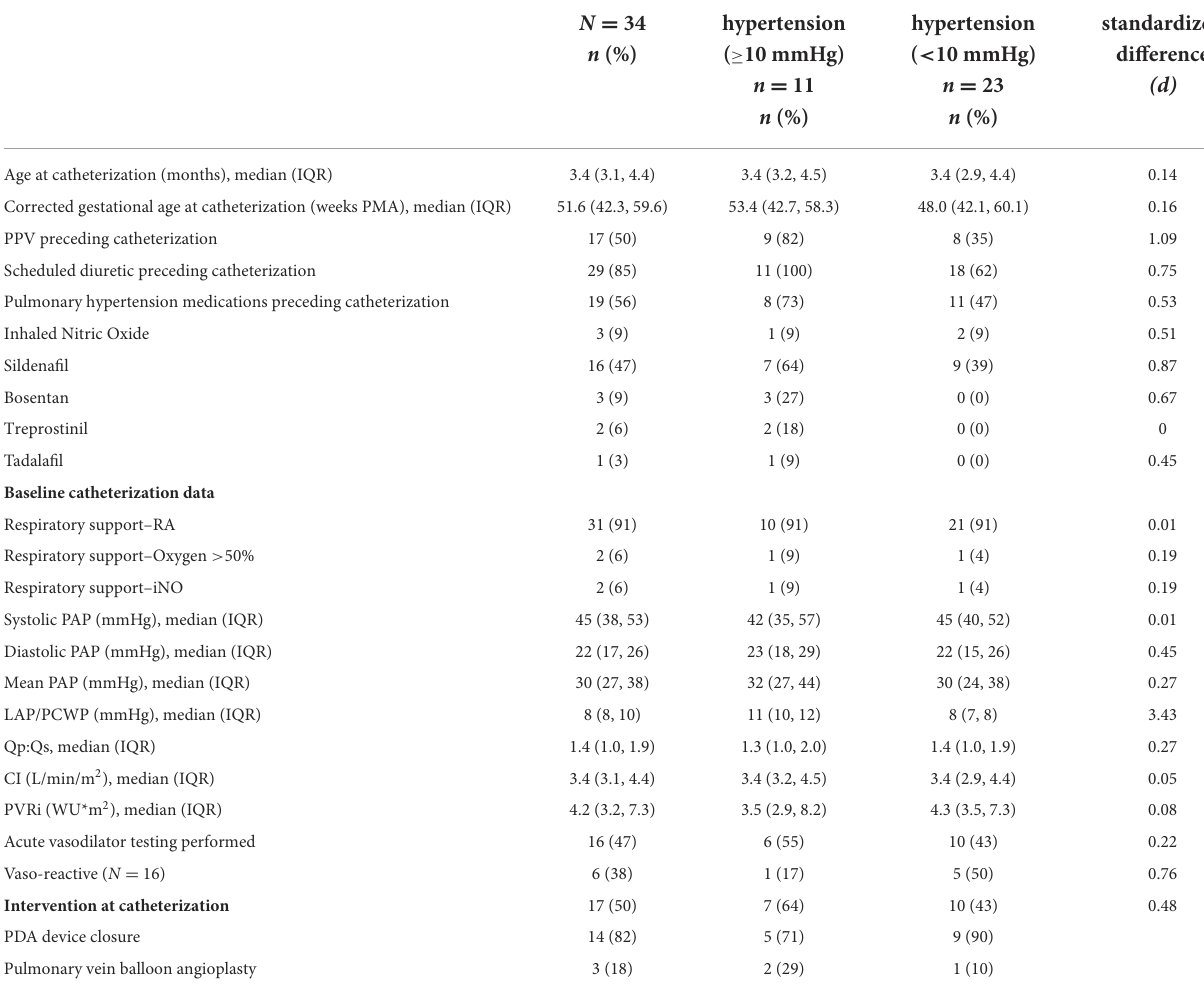
TABLE 2 Clinical characteristics at time of catheterization and invasive hemodynamics ( N = 34).